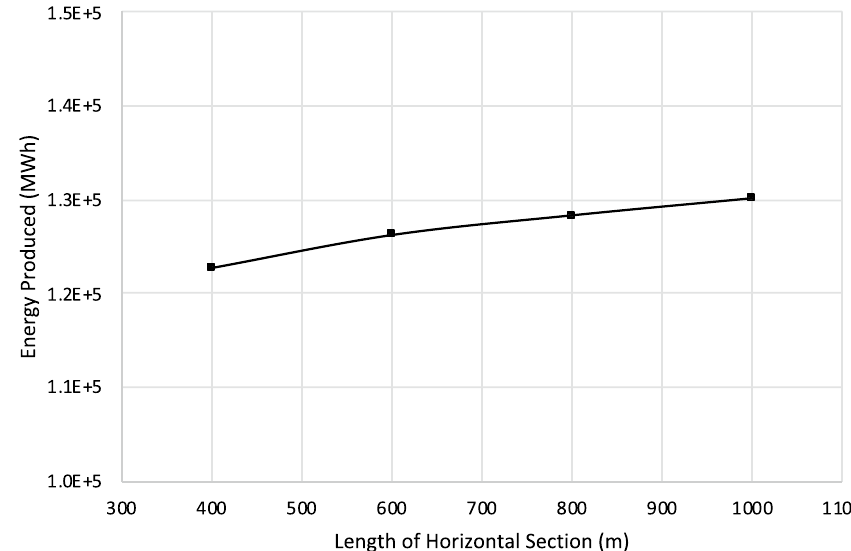
Fig. 10 Energy produced versus the length of the horizontal section for the closed-loop system at 200 m 3 / day fluid flow rate